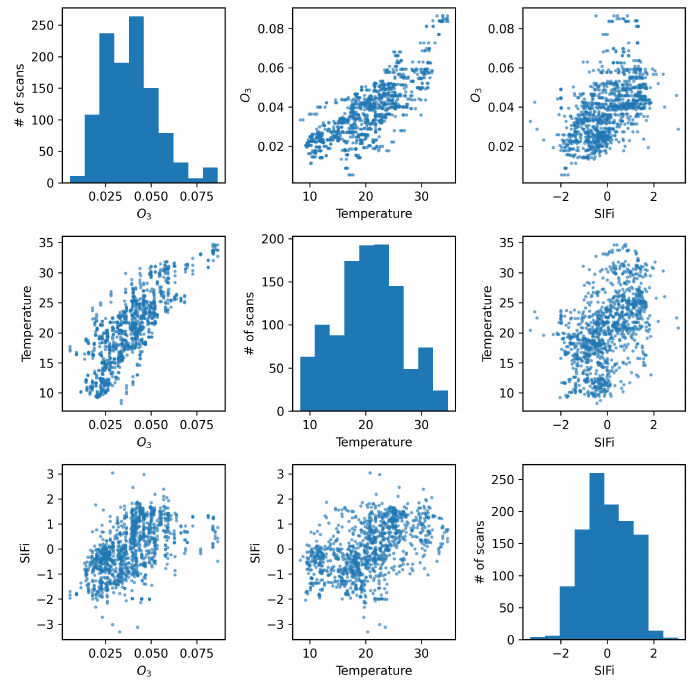
Figure 17. Scatter matrix showing the distribution of O 3 concentrations (in g/cm 3 ), temperature (in ◦ C), and SIFi and their